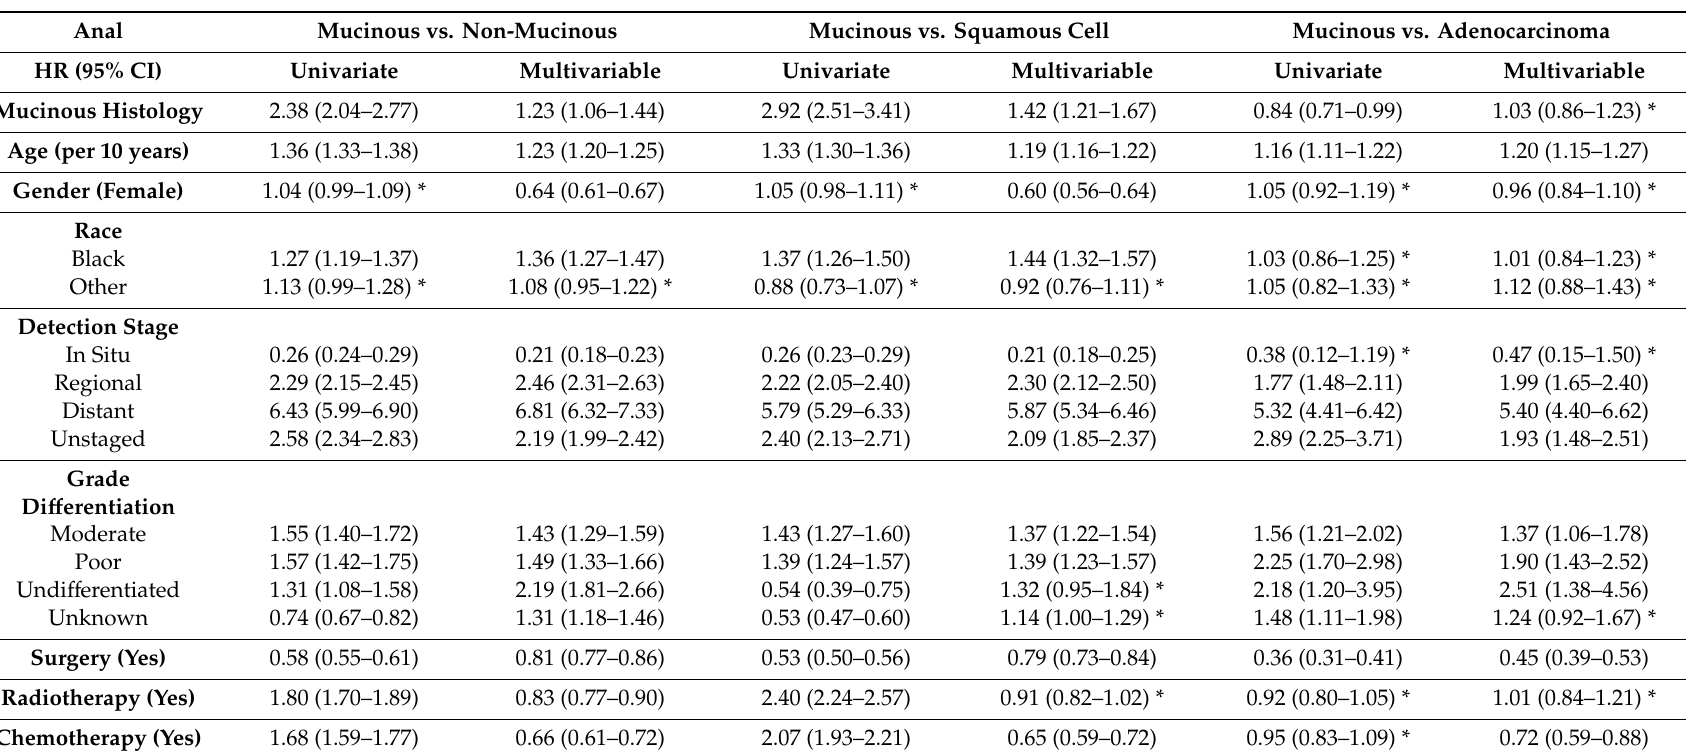
Table 26. Derived univariate and multivariable Cox-proportional hazard ratios (HR) of mortality for anal